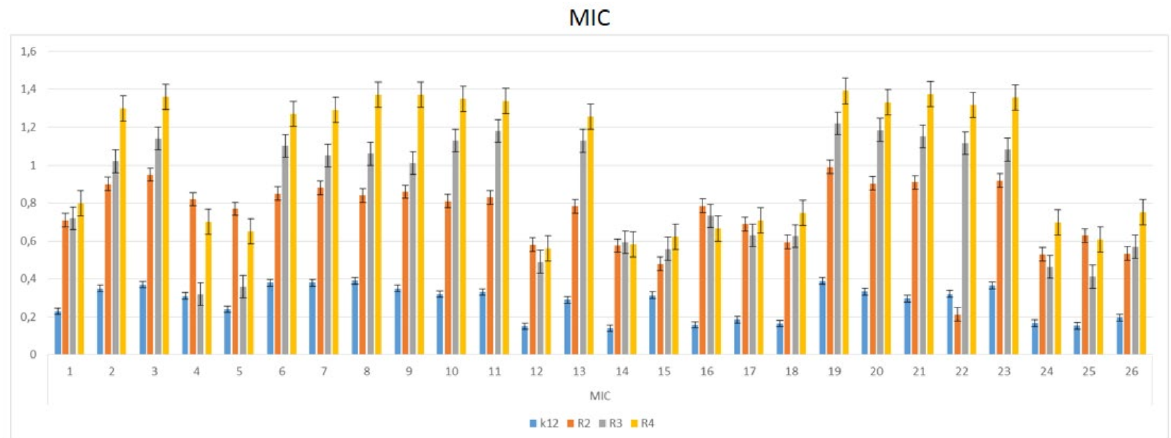
Figure 3. Minimum inhibitory concentration (MIC) of the amidoximes in model bacterial strains. The x -axis features amidoxime derivatives 1 – 26 used sequentially. The y -axis shows the MIC value in µ g/mL − 1 . Investigated strains of E. coli K12 as control (blue), R2 strains (orange), R3 strain (grey), and R4 strain (yellow). The y -axis shows the MBC value in µ g/mL − 1 . The order in which the compounds were applied to the plate are shown in Supplementary Materials Figure S1. Each experiment was performed independently in 3 replications ( n = 3).